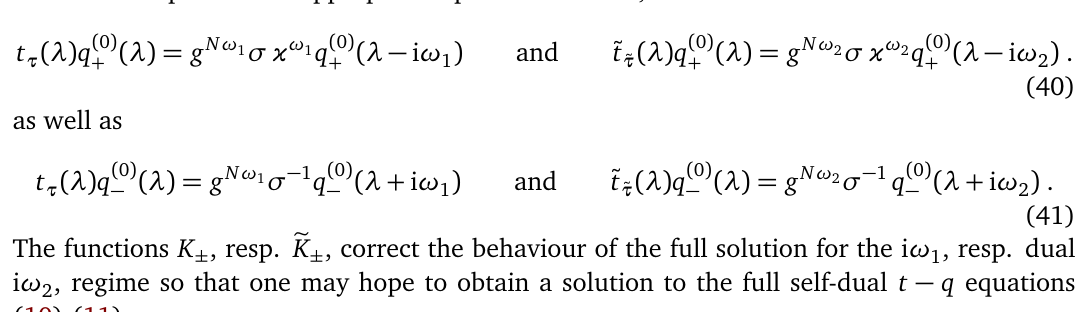
Figure 1: The strips B and